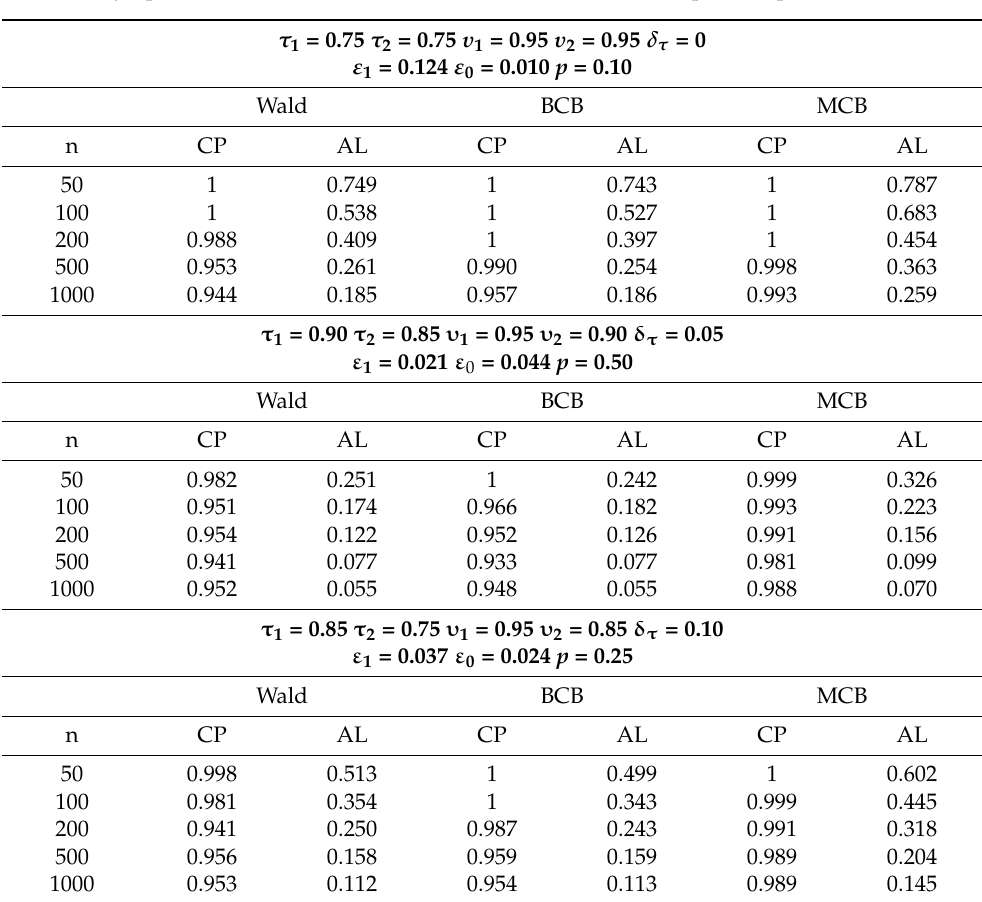
Table 2. Asymptotic behaviors of the CIs for the difference of the two positive predictive